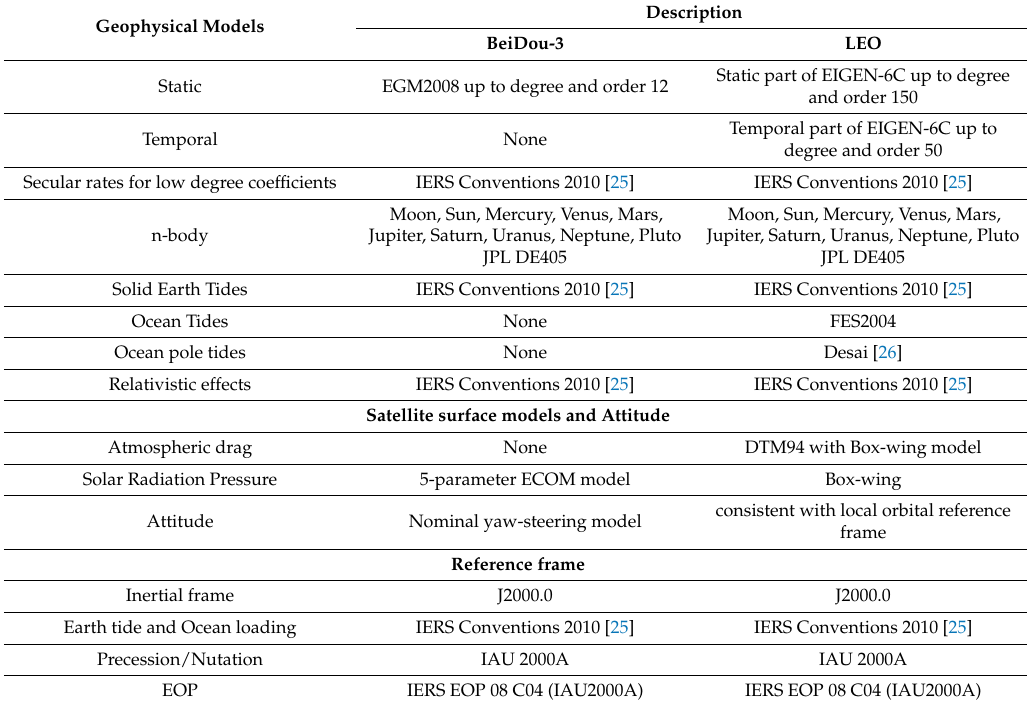
Table 3. Dynamic models used for generating the 24 h orbits for BeiDou-3 and LEO